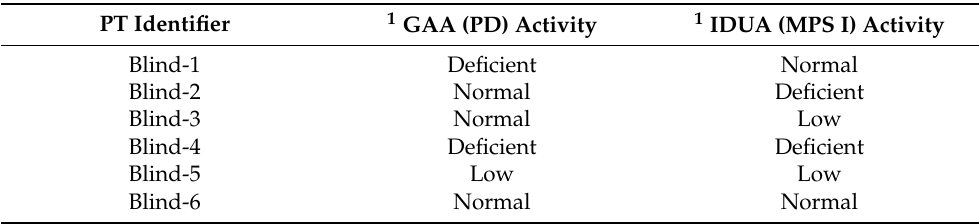
Table 1. Expected enzyme activities for PT specimens for GAA and